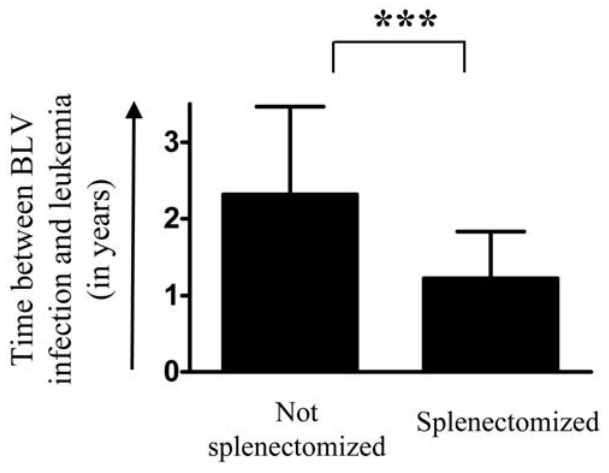
Figure 5. Development of leukemia in splenectomized animals. 10 BLV-infected sheep were splenectomized a few months after seroconversion (average delay: 4.6 months). Mean ( 6 SD) latency periods (time between seroconversion and leukaemia; leukocytes counts . 40 000/mm 3 ) in non operated BLV-infected sheep (n=29) and in splenectomized sheep (n=9). Statistical relevance (p , 0.001,